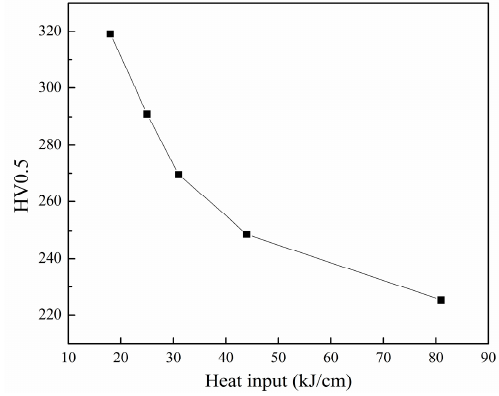
Figure 13. Hardness of the simulated CGHAZ at different heat input.